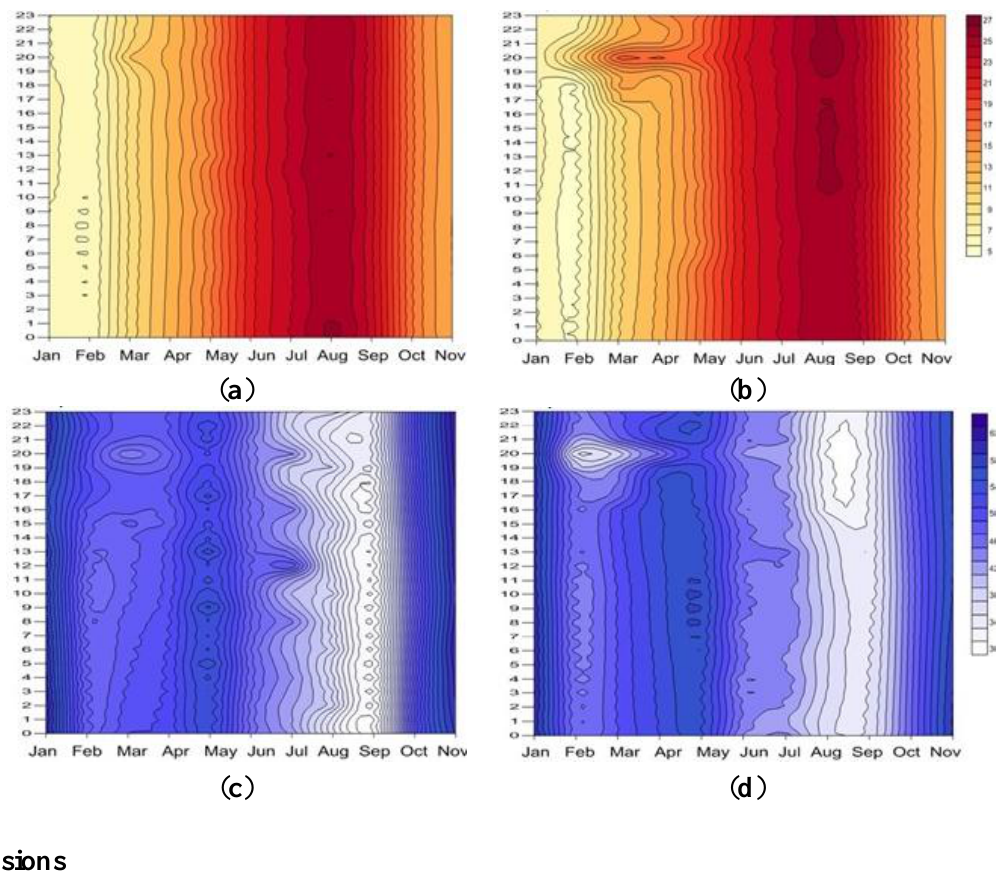
Figure 12. Annual contour plot of mean daily trajectories, of the average of sensors #1, #4, #8 and #12. The horizontal axis represents the months of the year (from January to November) and the vertical axis the hours of the day (0–23). ( a ) Temperature on Mondays, ( b ) temperature on Saturdays, ( c ) RH on Mondays, ( d ) RH